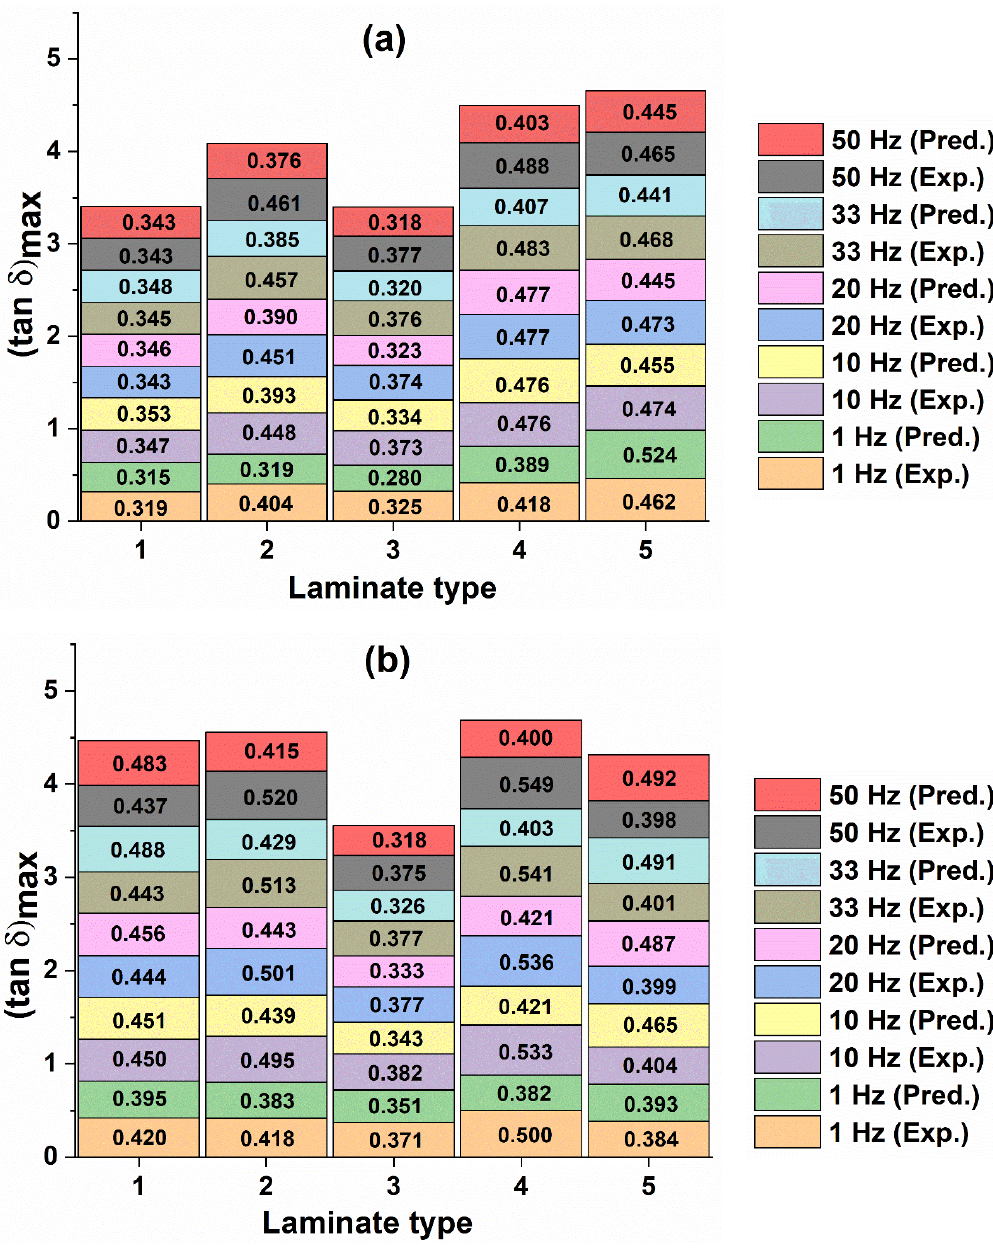
Figure 14. Comparison of predicted loss tangent values with experimental results for different types and frequencies of GFRP ( a ) and CFRP ( b ) composites.